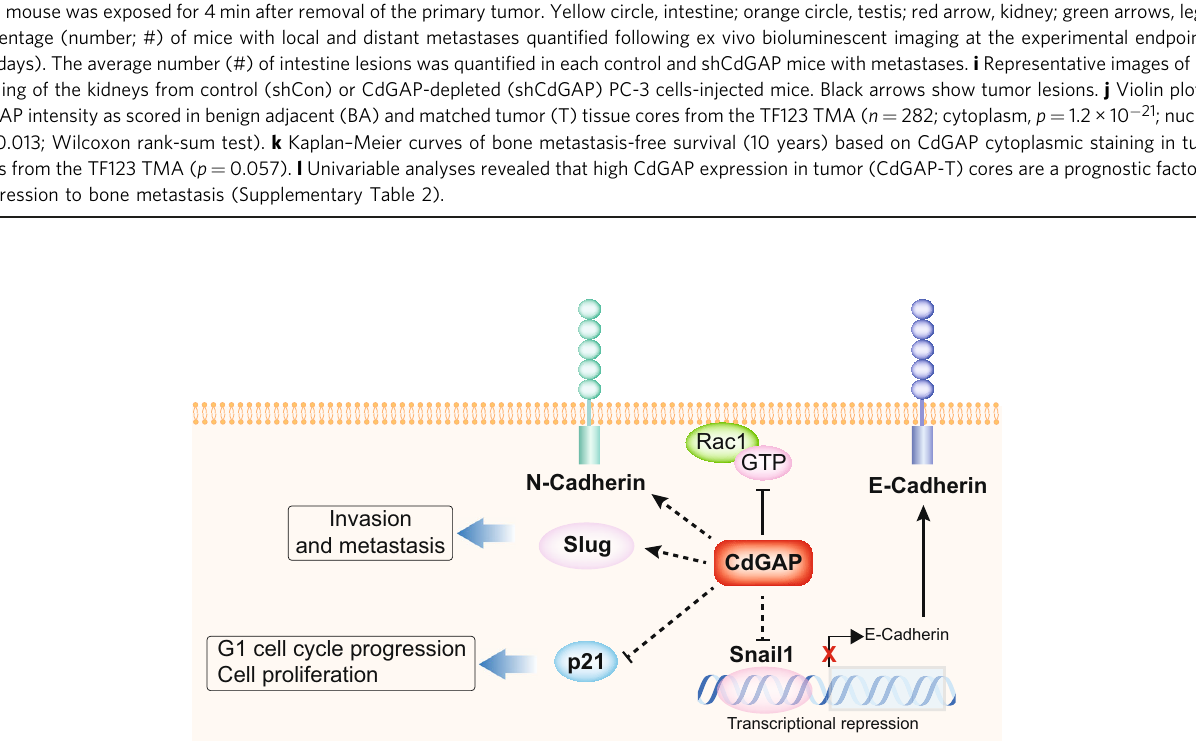
Fig. 9 Working model for the role of CdGAP in prostate cancer metastasis. High levels of CdGAP, a Rac1/Cdc42 inhibitor, are pro-oncogenic controlling cell invasion, metastasis, and proliferation. The mechanisms through which CdGAP promotes cell growth and migration involve the regulation of G1 cell cycle progression, apoptosis, and EMT genes. High levels of CdGAP result in increased expression of the mesenchymal markers N-cadherin and Slug, promoting invasion and metastasis while reduced levels of the CDK inhibitor p21 induce G1 cell cycle progression and cell proliferation. In addition, CdGAP negatively regulates the levels of the E-cadherin transcriptional repressor Snail1 in PC-3